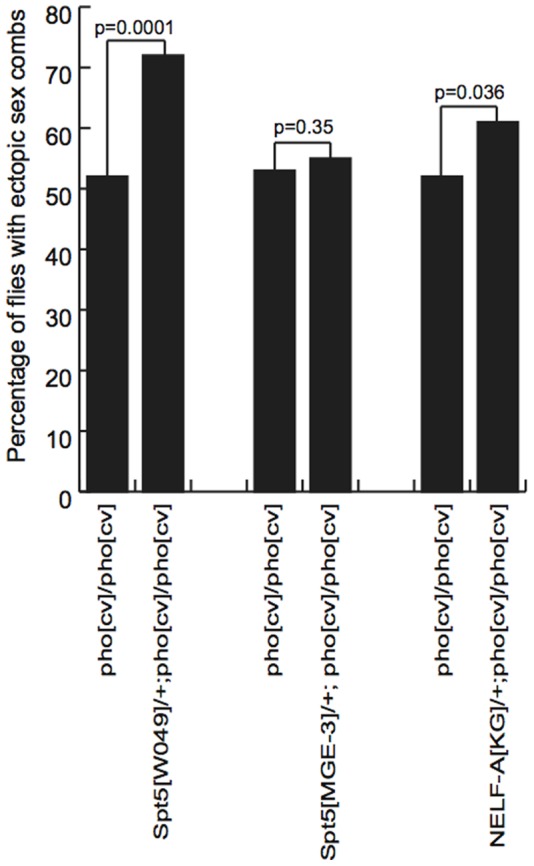
Modification of the extra sex combs phenotype of phocv/phocv mutants by Spt5 and NELF mutant alleles.A chart representing the frequency of ectopic sex combs in phocv/phocv mutants and siblings heterozygous for Spt5W049, Spt5MGE
−3 or NELF-AKG over wild-type chromosomes. p values from two proportion z-tests are shown.